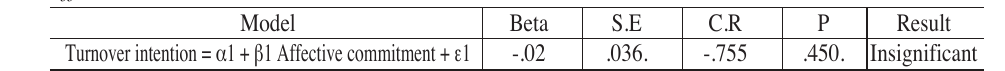
Affective Commitment and Turnover Intention